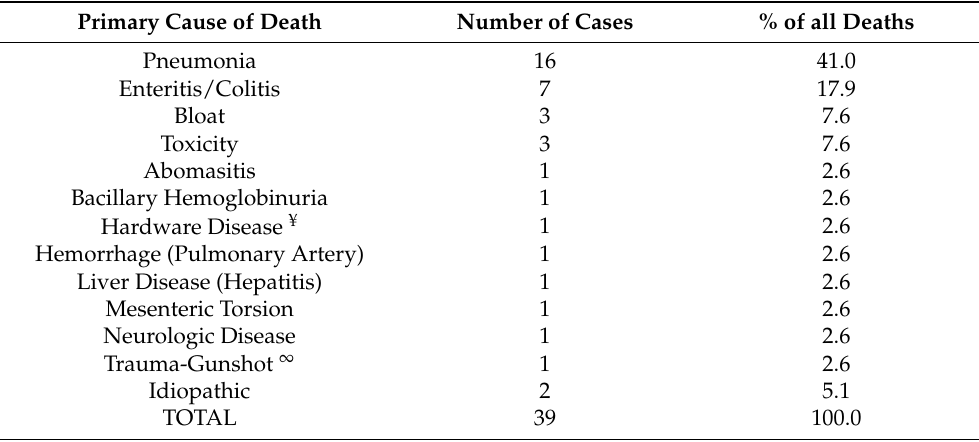
Table 6. Primary cause of death of 39 calves 6 months to 1 year old diagnosed at